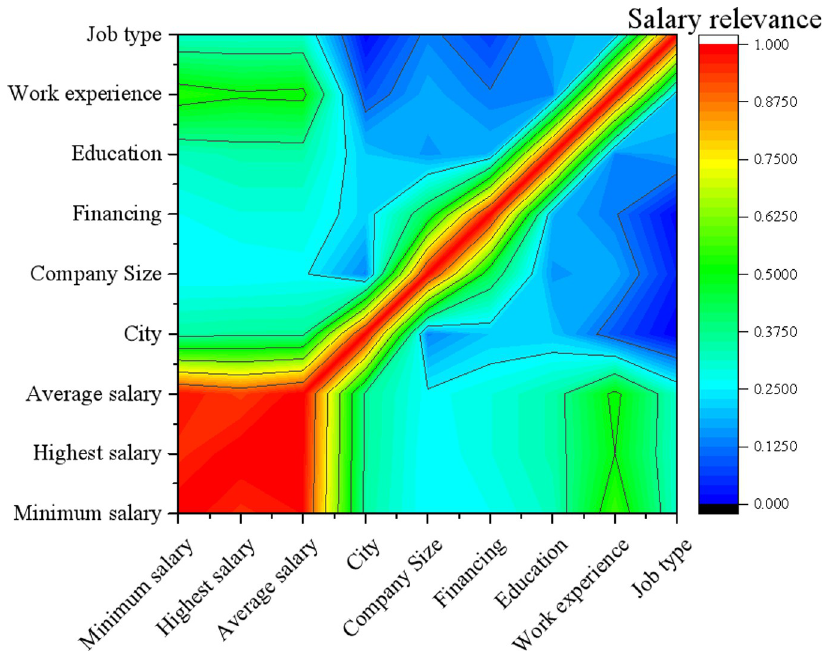
Fig 7. Analysis of salary